Question: Based on the figure, does the quantity rise or fall?
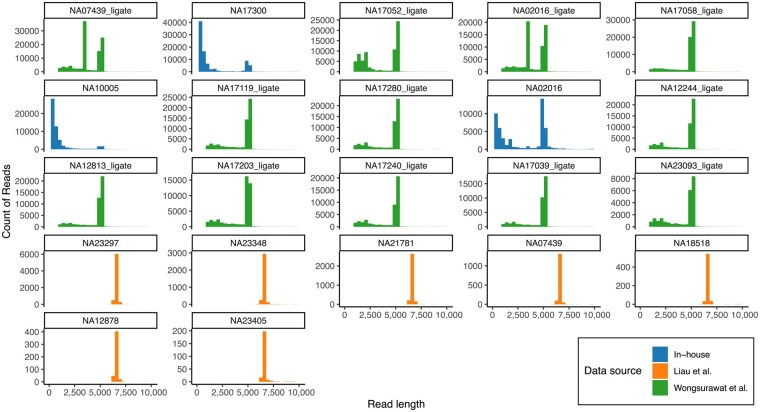
Answer: decreasing